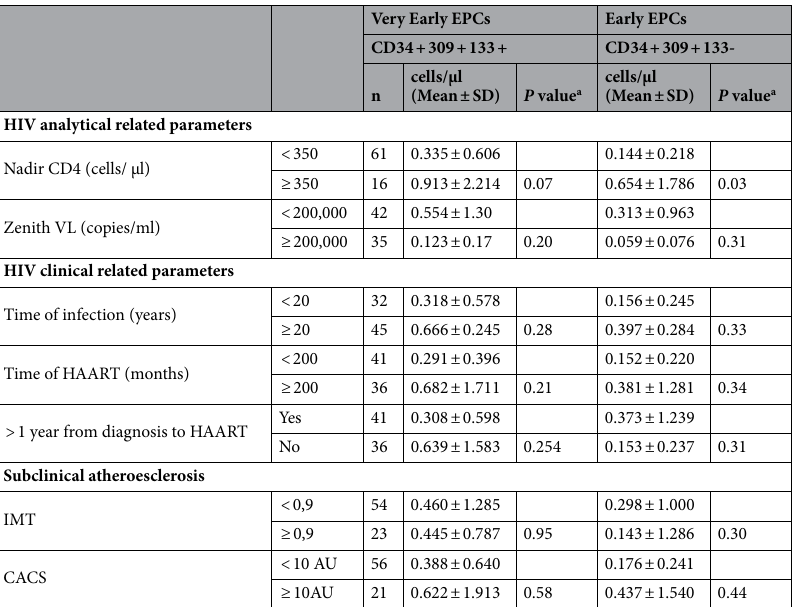
Very Early EPCs Early